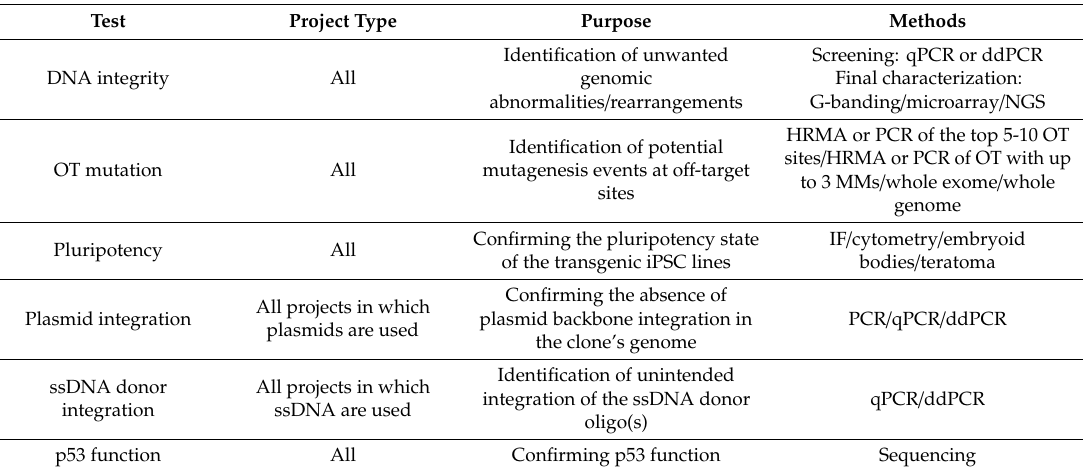
Table 2. In-depth molecular characterization